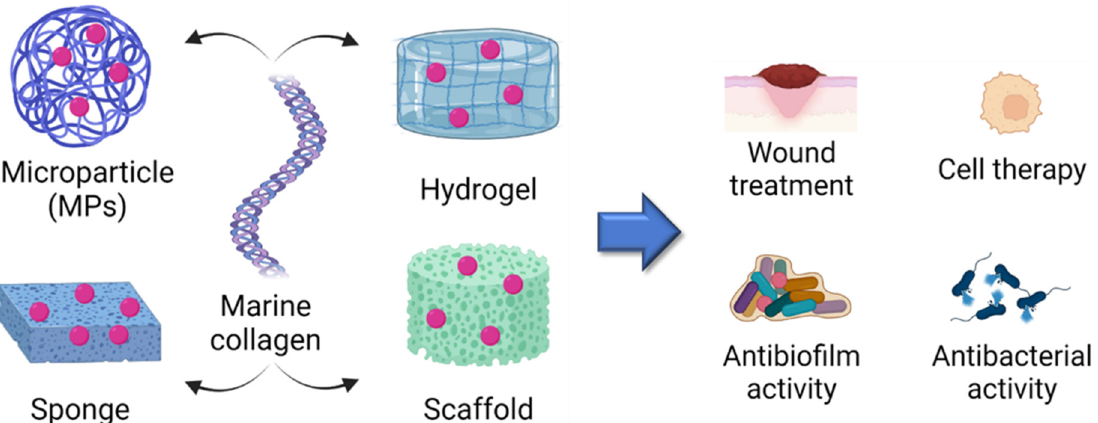
Figure 6. Marine collagen microparticles (MPs), sponges, hydrogels and scaffolds, and their appli- cation as delivery systems (wound treatment; cell therapy; antibiofilm and antibacterial activity). Created with BioRender.com.